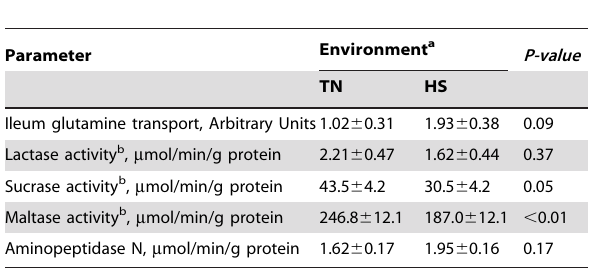
Table 3. The effects of 24 h of thermal neutral (TN) or heat stress (HS) conditions on intestinal glutamine transport and digestive enzymes in growing